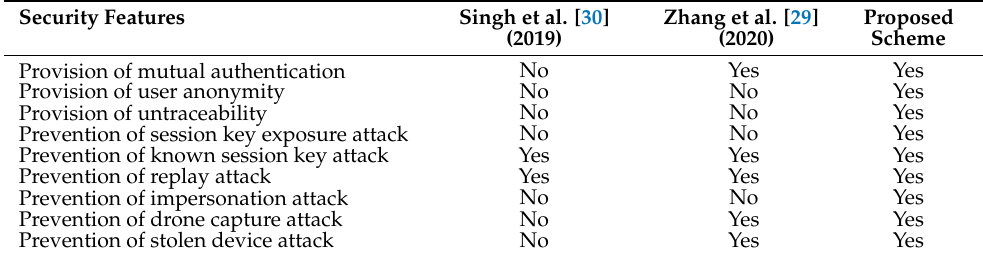
Table 1. Comparison of security features.